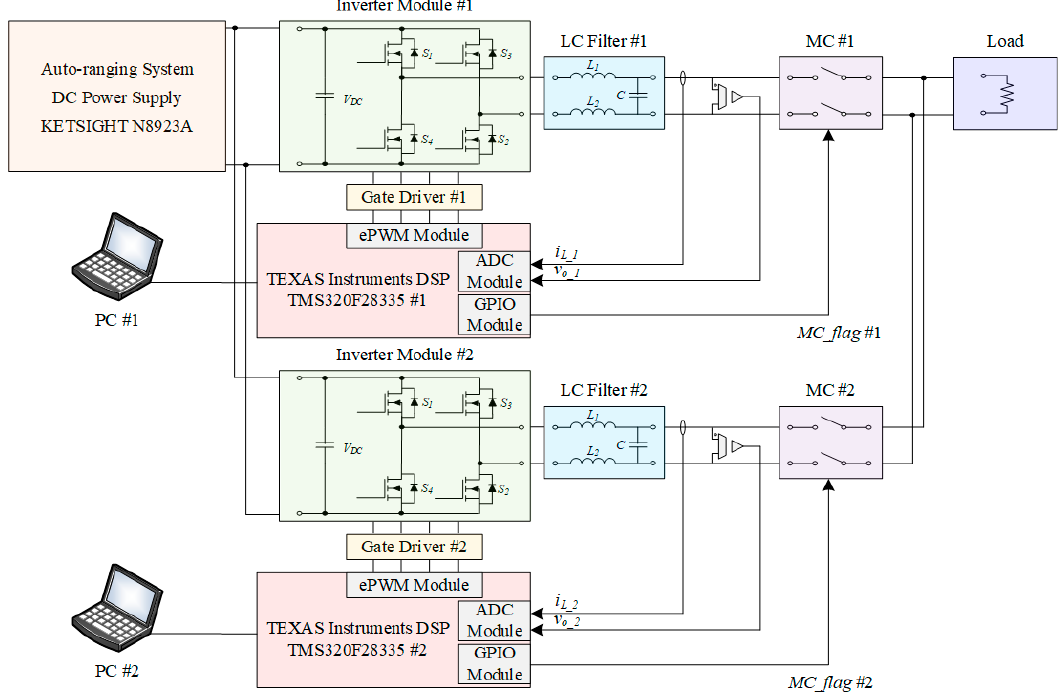
Figure 10. Control block diagram of droop-controlled parallel-inverter using the proposed control strategy.